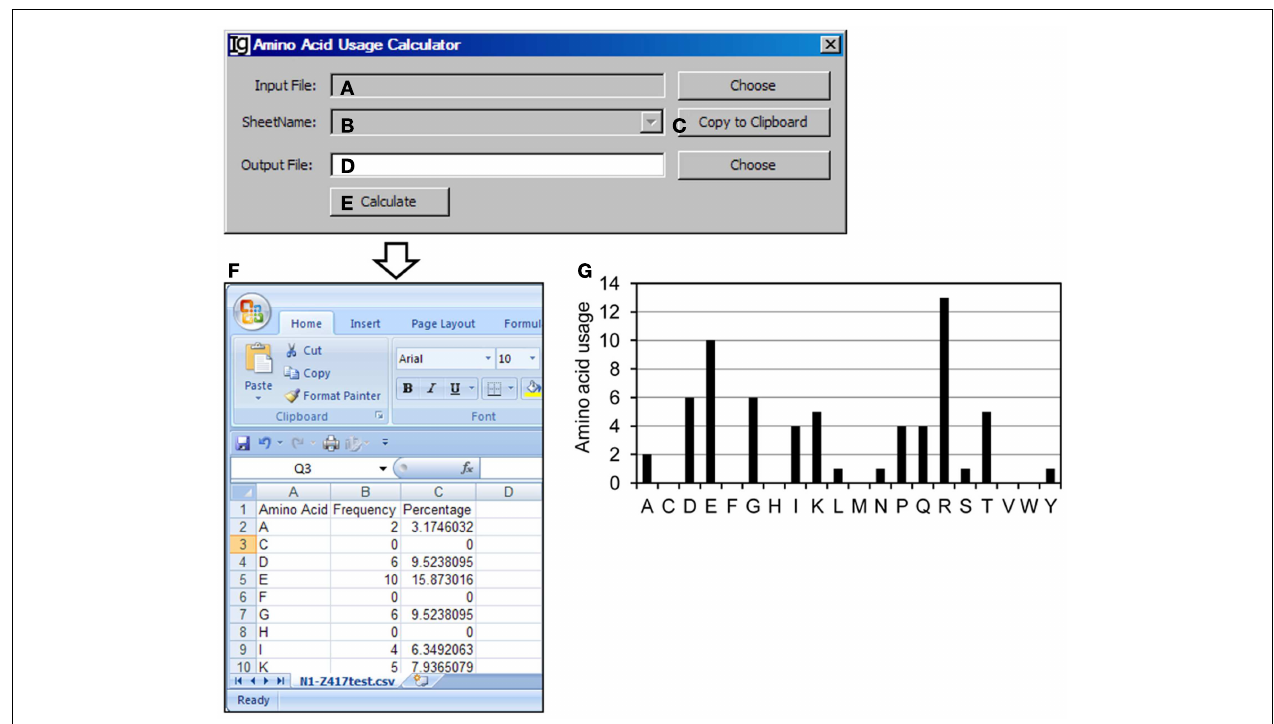
FIGURE 9 |The amino acid usage calculator . Diagram shows the interface of the Amino Acid Usage Calculator. (A) Button to choose the amino acid analysis result file. (B) Combo box for choosing the sheet to analyze. (C) Button to copy the name of the selected sheet to the clipboard. (D) Button to choose the output file. (E) Button to start the calculation process. (F) The output results of amino acid usage in Excel format. (G) Bar graph shows the amino acid usages.